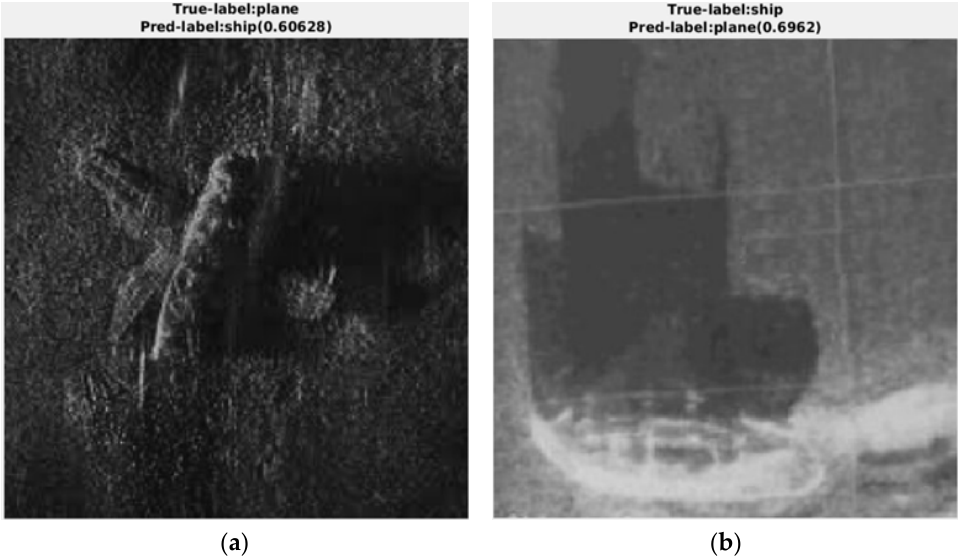
Figure 16. Misclassification samples: ( a ) A sample of an airplane which was misclassified as a ship; ( b ) A sample of a ship which was misclassified as an airplane.